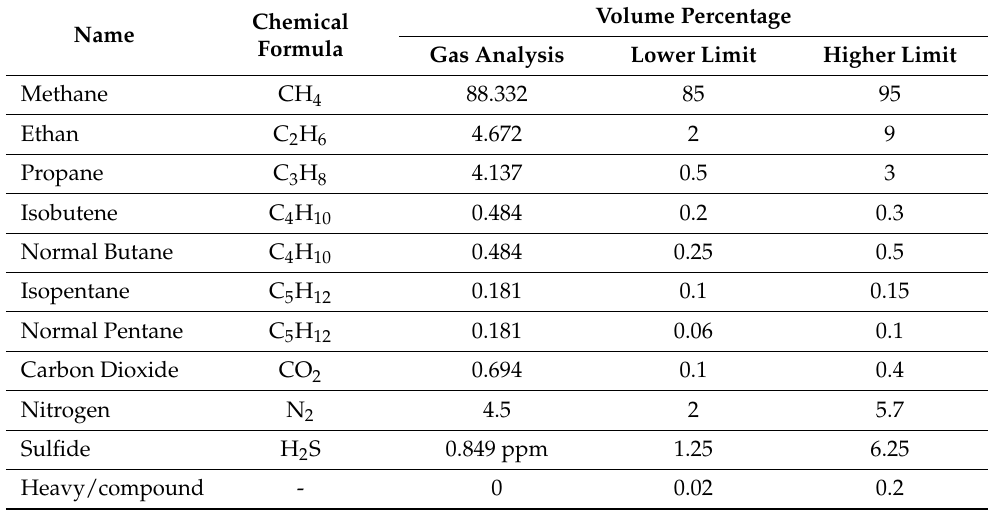
Table 1. Volumetric fraction of natural gas composition [24].